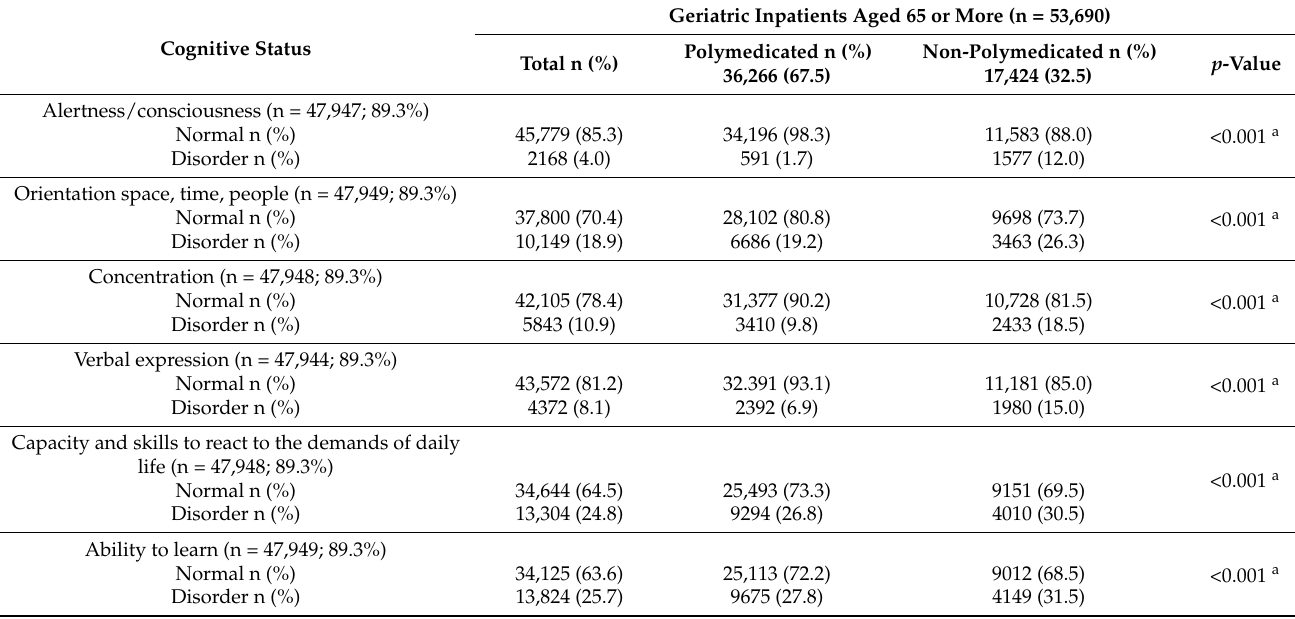
Table 3. Distribution and comparison of cognitive status among polymedicated (n = 36,266) and non-polymedicated (n = 17,424) geriatric